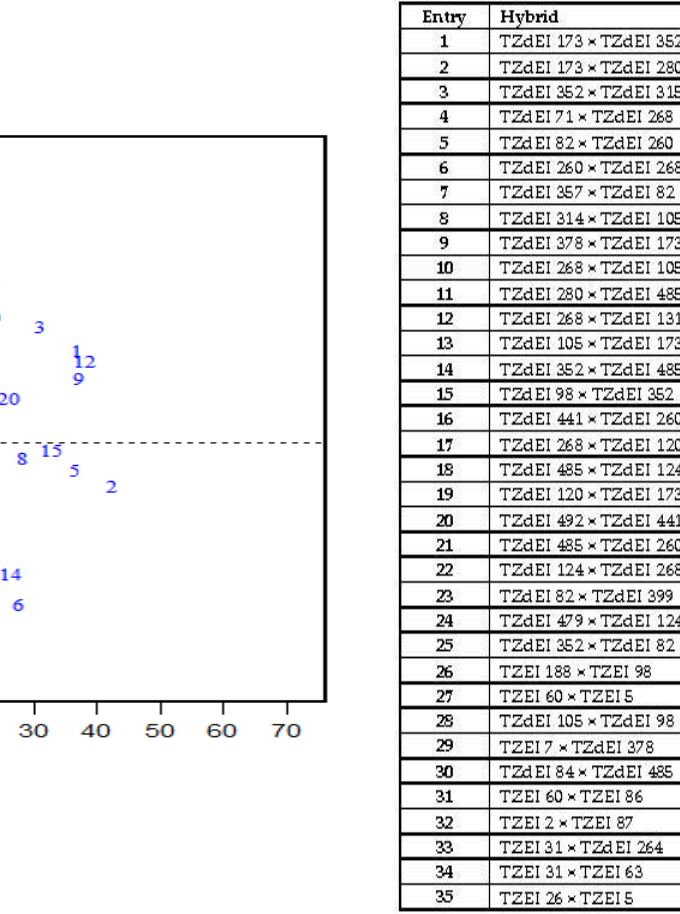
Figure 1. AMMI biplot of mean performance and stability of selected early maturing maize hybrids in terms of grain yield as measured by principal components across three Striga -infested environments in Nigeria between 2013 and 2015. E1 = Abuja , 2013 ; E2 = Mokwa , 2013 ; E3 = Abuja , 2015 . The y axis represents the grand mean of the grain yield, while the x axis represents the principal component axes 1 (IPCA1) value of zero.